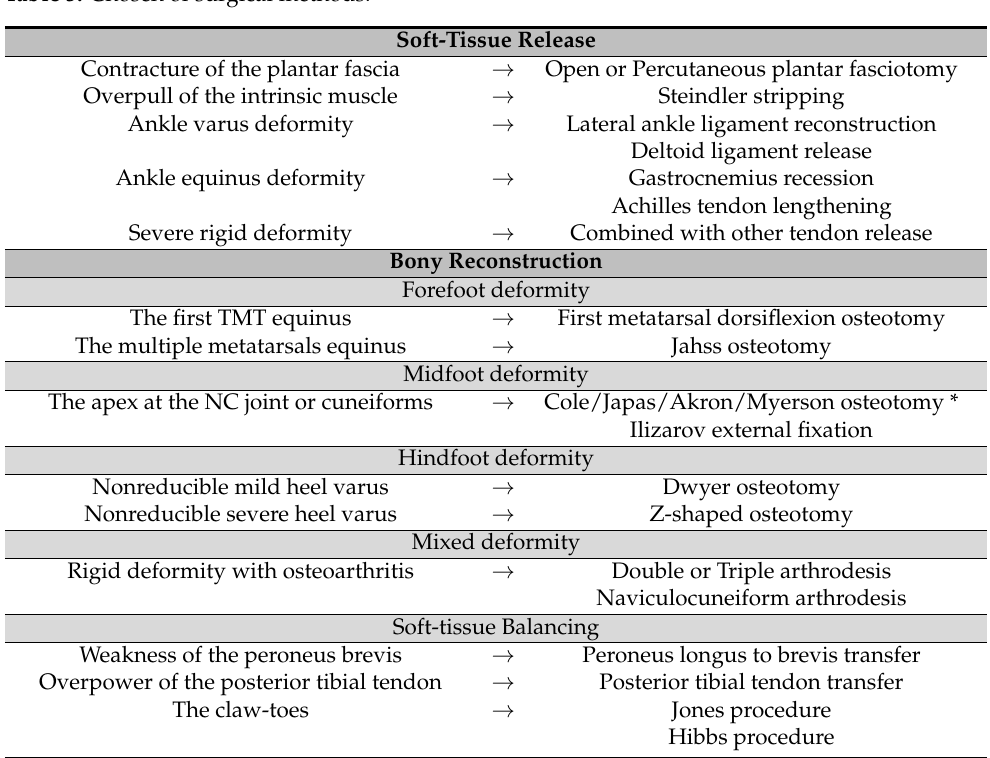
Table 3. Chosen of surgical